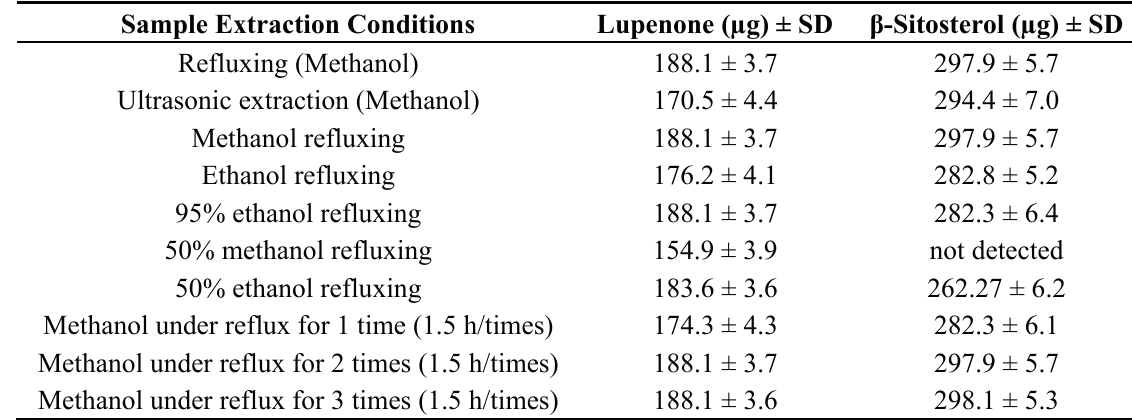
Table 1. Optimization of sample extraction